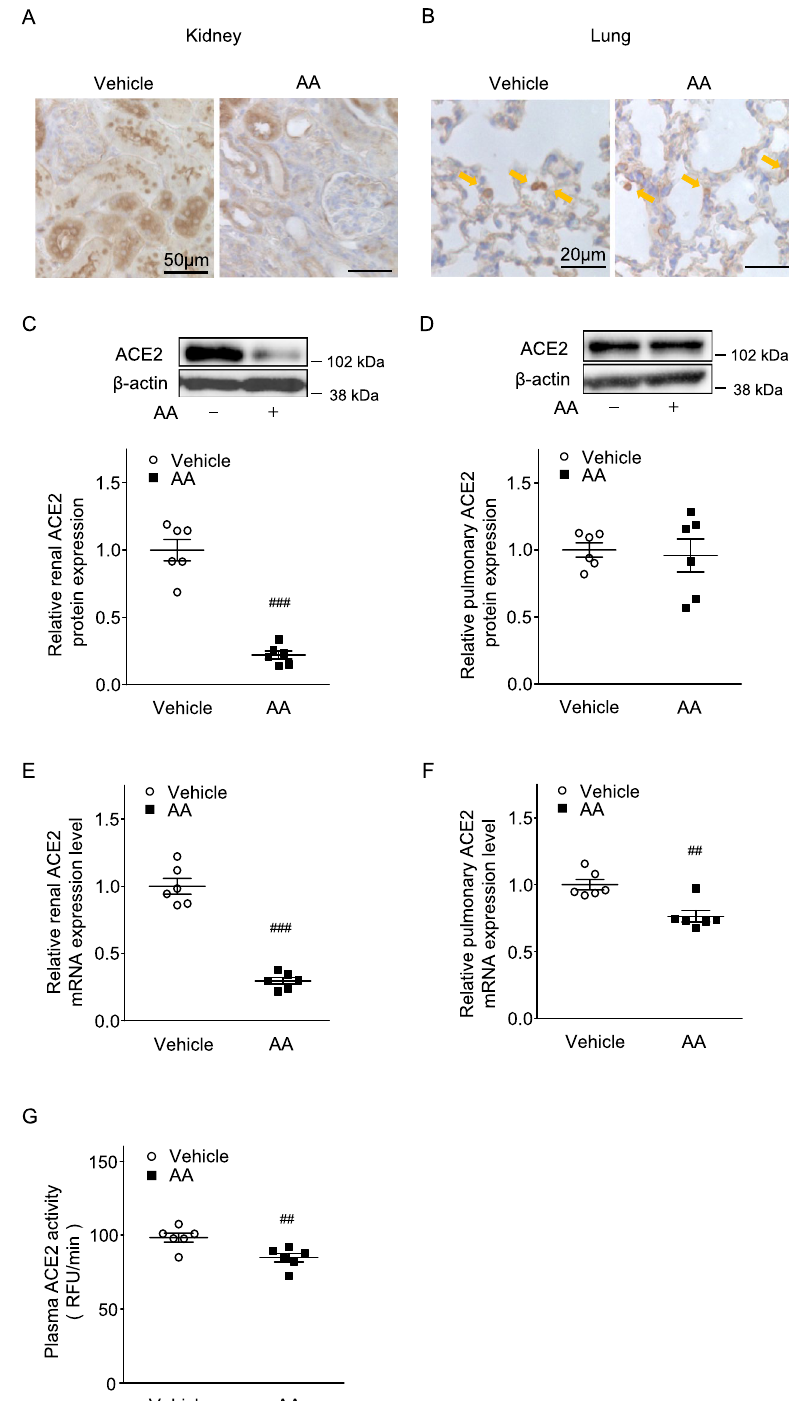
Figure 4. Renal and pulmonary ACE2 expression levels and plasma ACE2 activity in aristolochic acid (AA)- induced CKD model mice. ( A ) Representative image of renal ACE2 immunostaining at 8 weeks after treatment in vehicle and AA groups. Bars = 50 µm. ( B ) Representative image of pulmonary ACE2 immunostaining at 8 weeks after treatment in vehicle and AA groups. Bars = 20 µm. ( C ) Renal ACE2 protein expression levels and ( E ) mRNA expression levels in vehicle and AA groups. ( D ) Pulmonary ACE2 protein expression levels and ( F ) mRNA expression levels in vehicle and AA groups. ( G ) Plasma ACE2 activity in vehicle and AA groups. Values are expressed as mean ± standard error of the mean (six mice per group). P values, versus vehicle: # P < 0.05; ## P < 0.01; ### P < 0.001. CKD, chronic kidney